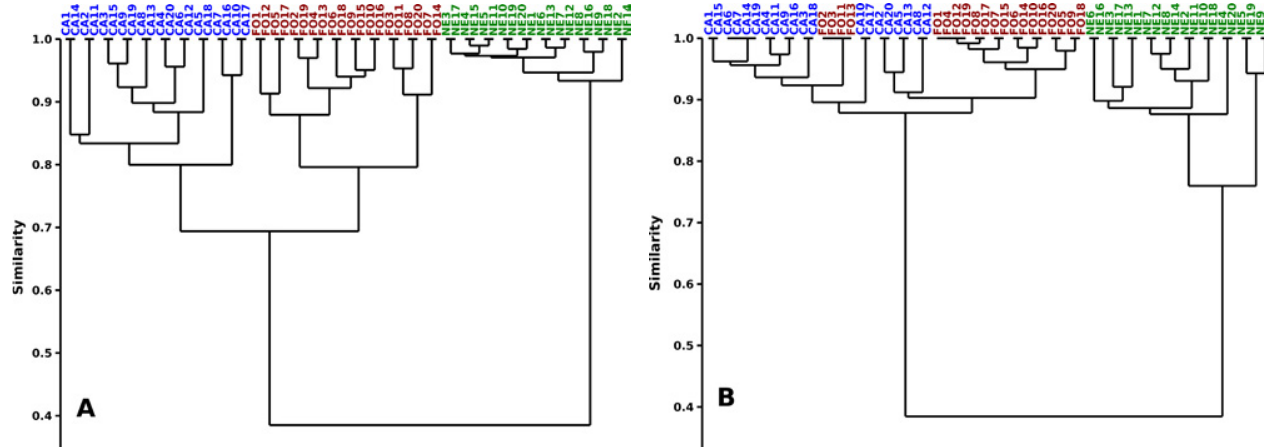
Fig 2 . Dendrograms obtained from a hierarchical cluster analysis (HCA). The groups were formed according to similarities in the cephalic salivary gland secretion (A) and cuticle surface (B) chemical profiles of Melipona quadrifasciata . Both dendrograms showed that nurses (CA) and foragers (FO) are closest. NE = newly emerged workers.